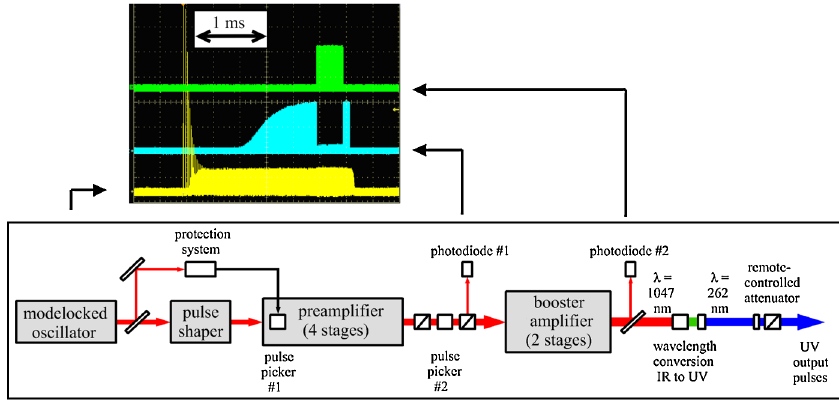
FIG. 6. (Color) Scheme of the laser and pulse trains recorded at several positions in the